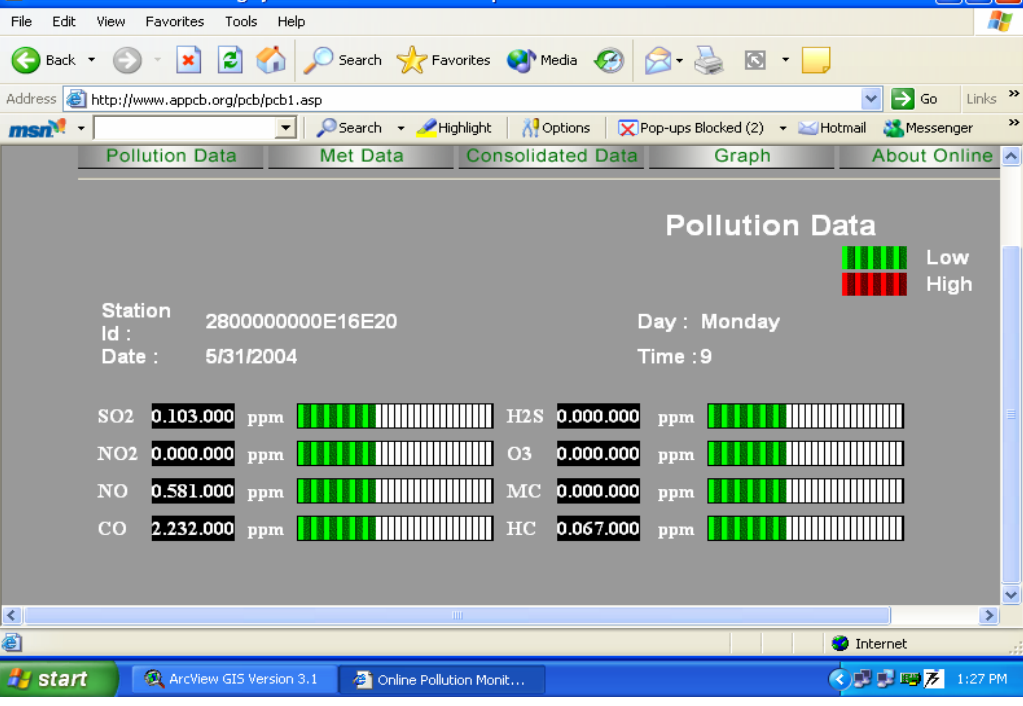
Figure 7: Components of online air pollution monitoring